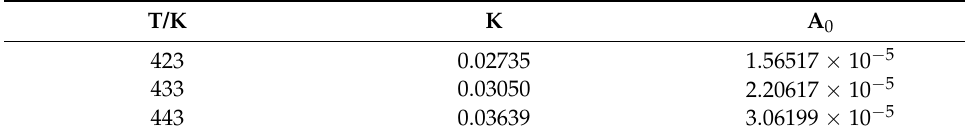
Figure 18. Changes in the relative viscosity with time at different temperatures. Table 5. The values of K and A 0 at different temperatures.